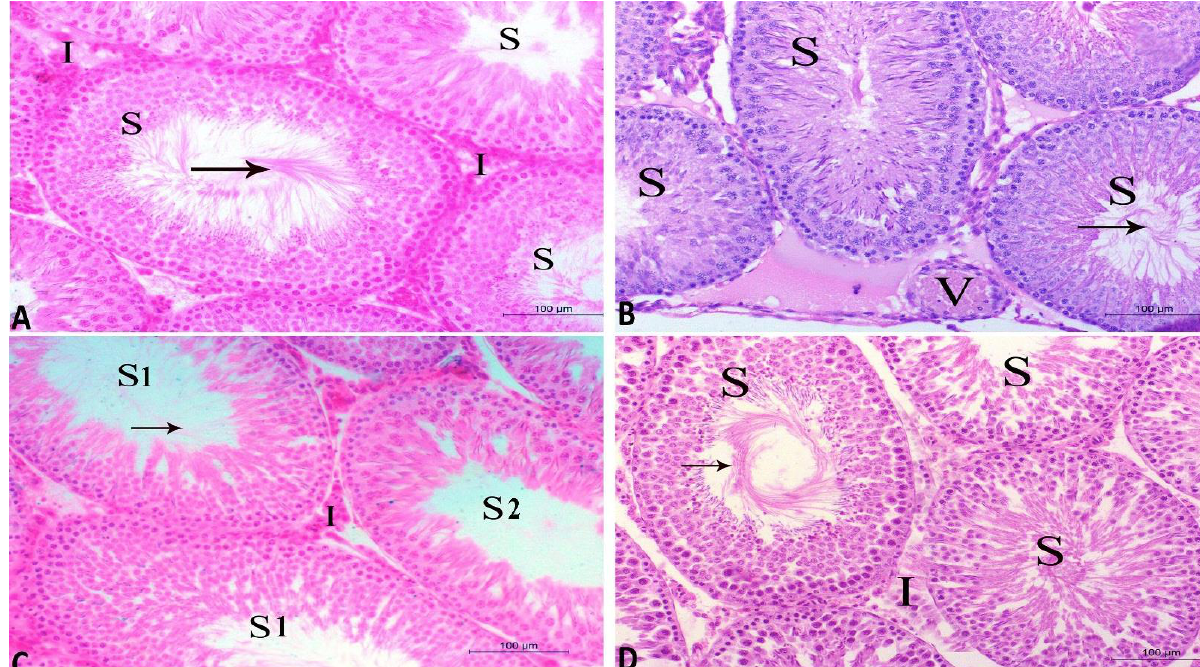
Figure 6. Histopathological characteristics of seminiferous tubules of testes from the four studied rat groups ( A – D ) using hematoxylin and eosin (H and E) staining and magnification × 200. ( A ) Control group appearance with normal seminiferous tubules (S) containing normal spermatogenic cells and spermatid as well as normal interstitial tissues (I) ( B ) CdCl 2 group showing seminiferous tubules (S) lined with degenerated spermatogenic cells and low amounts of spermatid and sperms (arrow). Note, the interstitial tissues contain congested blood vessels (V) and inactive Leydig cells. ( C ) CdCl 2 and Vit. E group show normal seminiferous tubules (S1). The other tubules (S2) are lined with degenerated spermatogenic cells with a few sperms. The interstitial tissues contain normal blood capillaries and less active Leydig cells (I). ( D ) CdCl 2 and RCME group show normal seminiferous tubules (S) with spermatogenic cells and sperms (arrow). The interstitial tissues (I) appear normal.